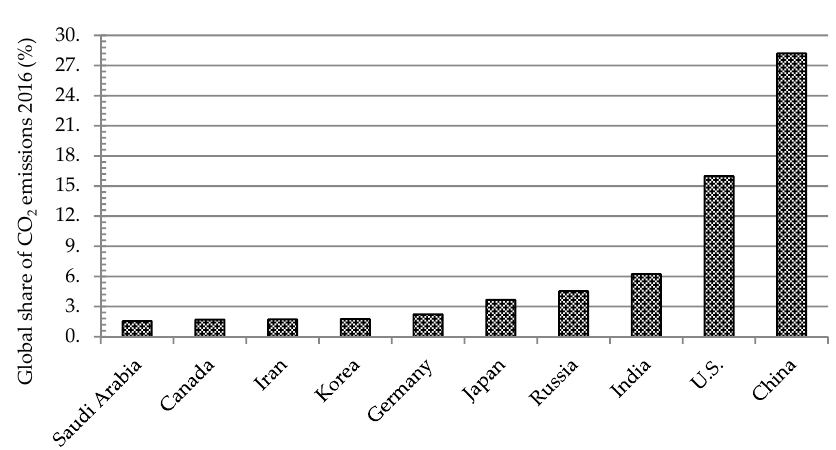
Figure 4. Carbon dioxide emission by country for year 2016. (Source: Germanwatch, the Climate Change Performance Index 2017).